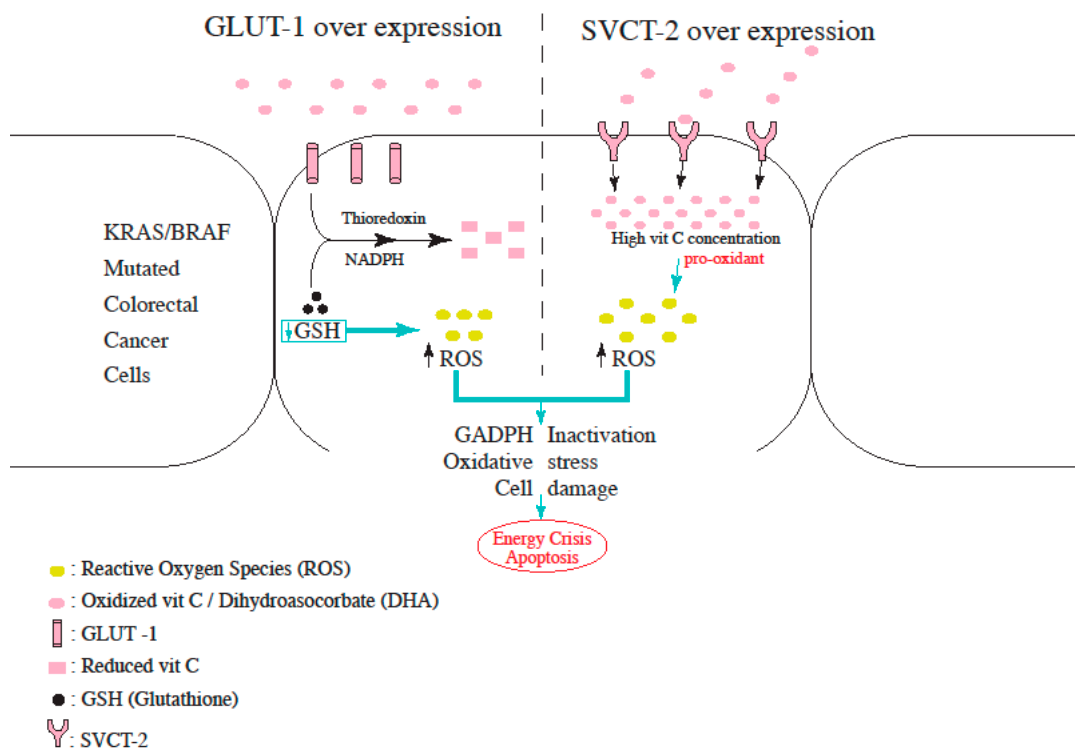
Figure 2. Proposed mechanism for increased ROS production in L-Ascorbic Acid-treated cells overexpressing either GLUT-1 or SVCT-2.